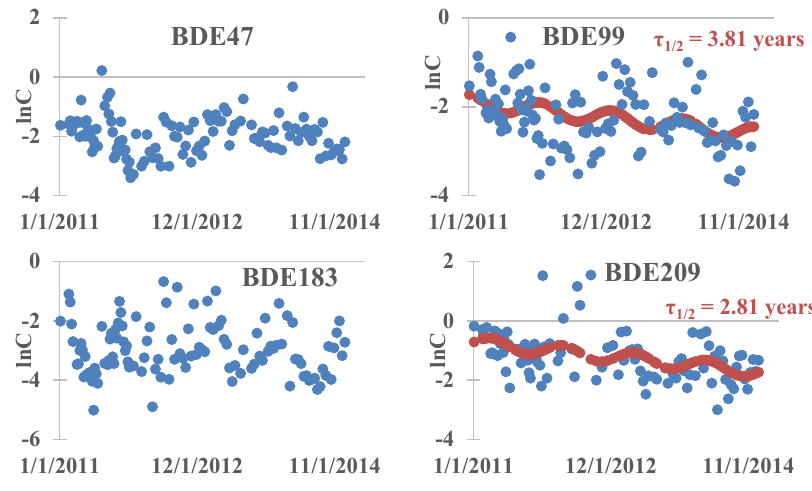
Figure 4. Multi-year trends of the most abundant